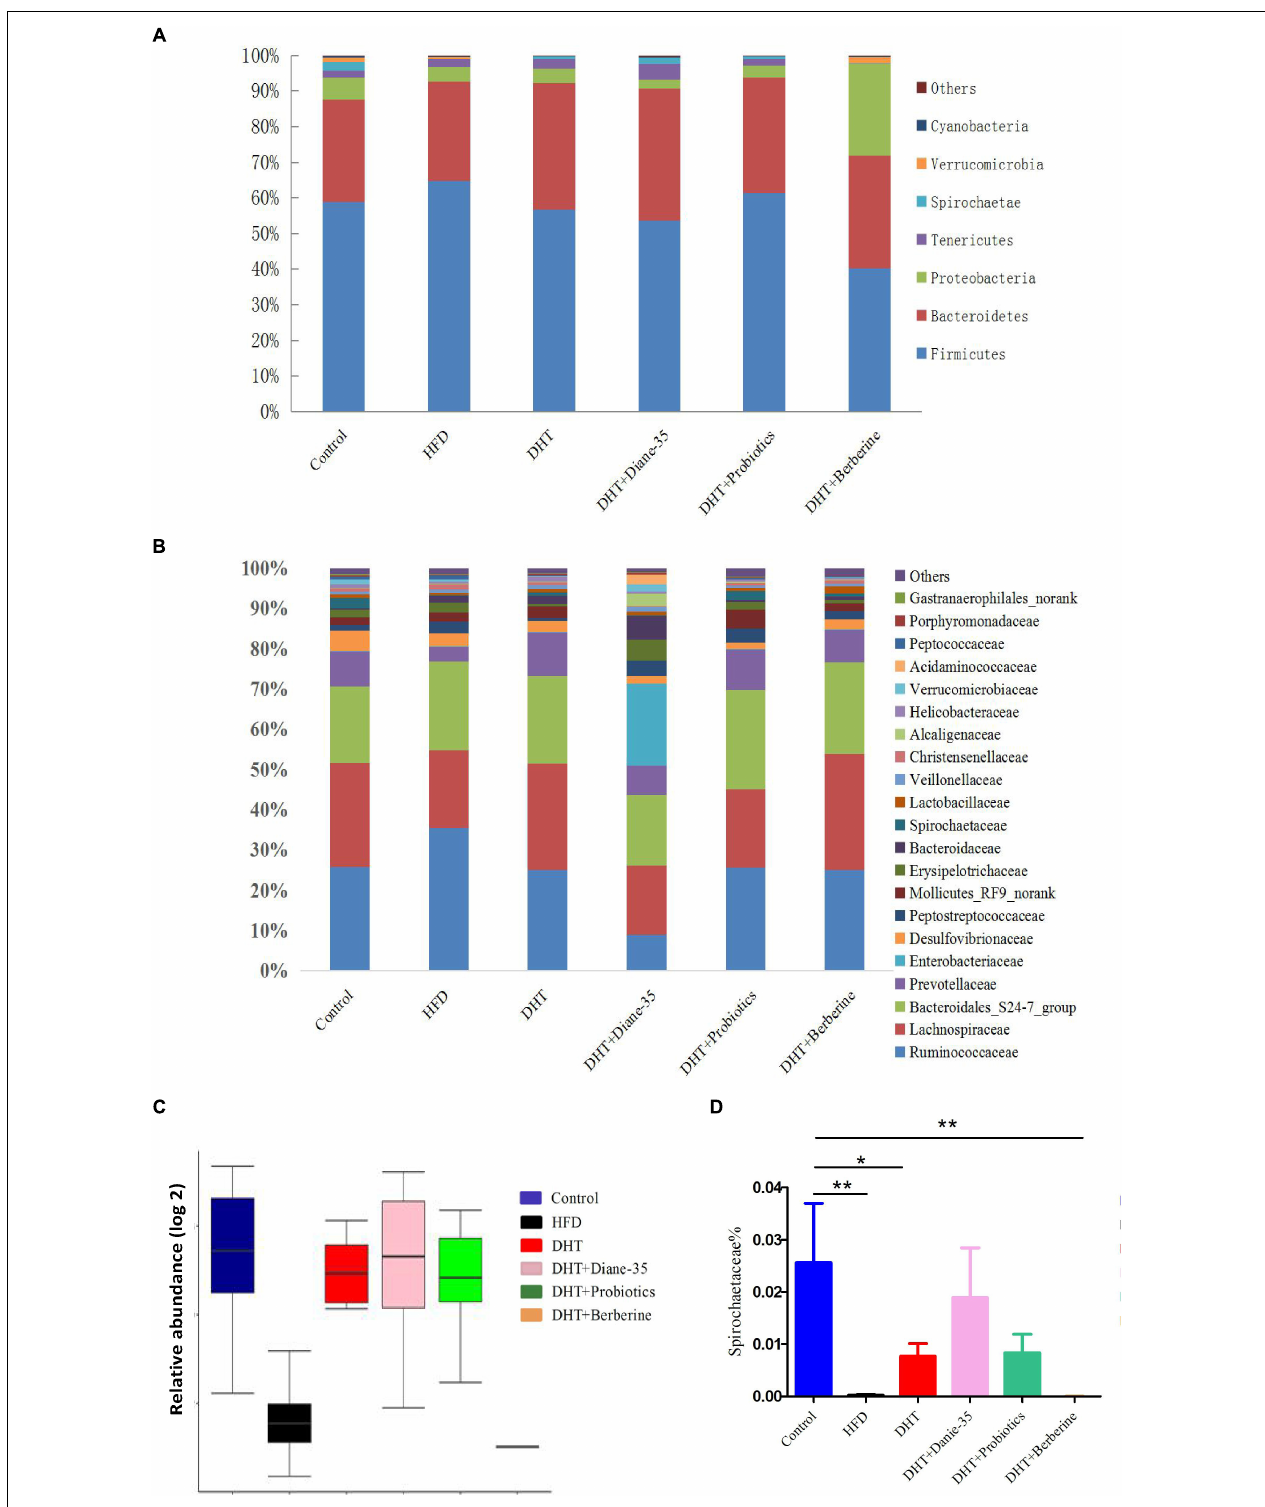
FIGURE 5 | (A) Composition of the gut microbiota in different groups at the phylum level. (B) Composition of the gut microbiota in different groups at the family level. (C) The abundance of Spirochaetae at the phylum level. (D) The abundance of Spirochaetaceae at the family level. Values are presented as mean ± SEM, ∗ p < 0.05, ∗∗ p <